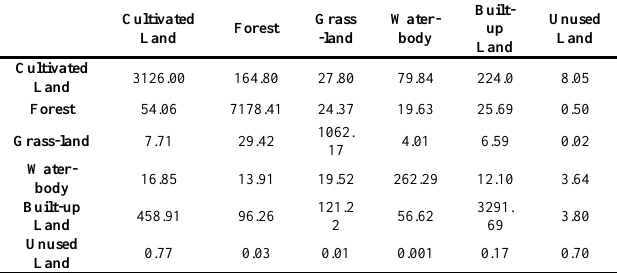
Table 4. Conversion of Land Types from 2020 to 2035 (km 2 ).